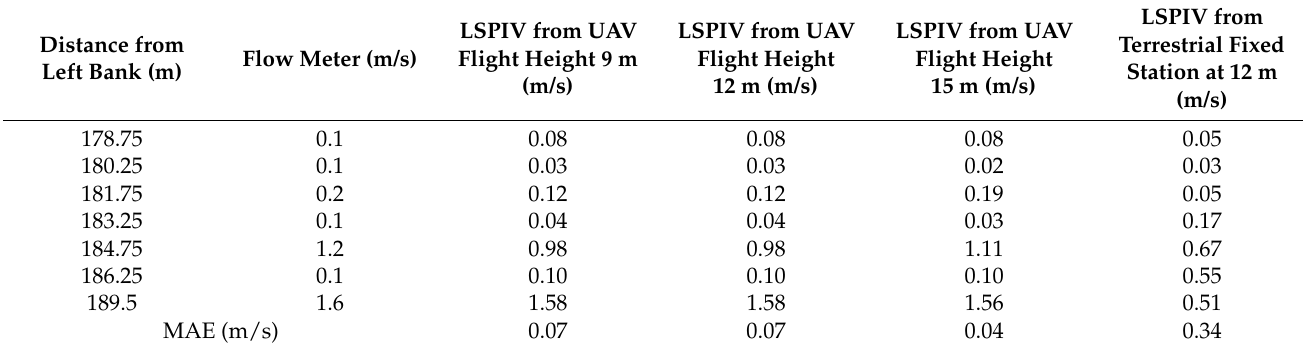
Table 2. The statistical error and the measured surface velocity using LSPIV determined by a UAV held at different flight heights and that of a terrestrial fixed station compared to the results of a flow meter.